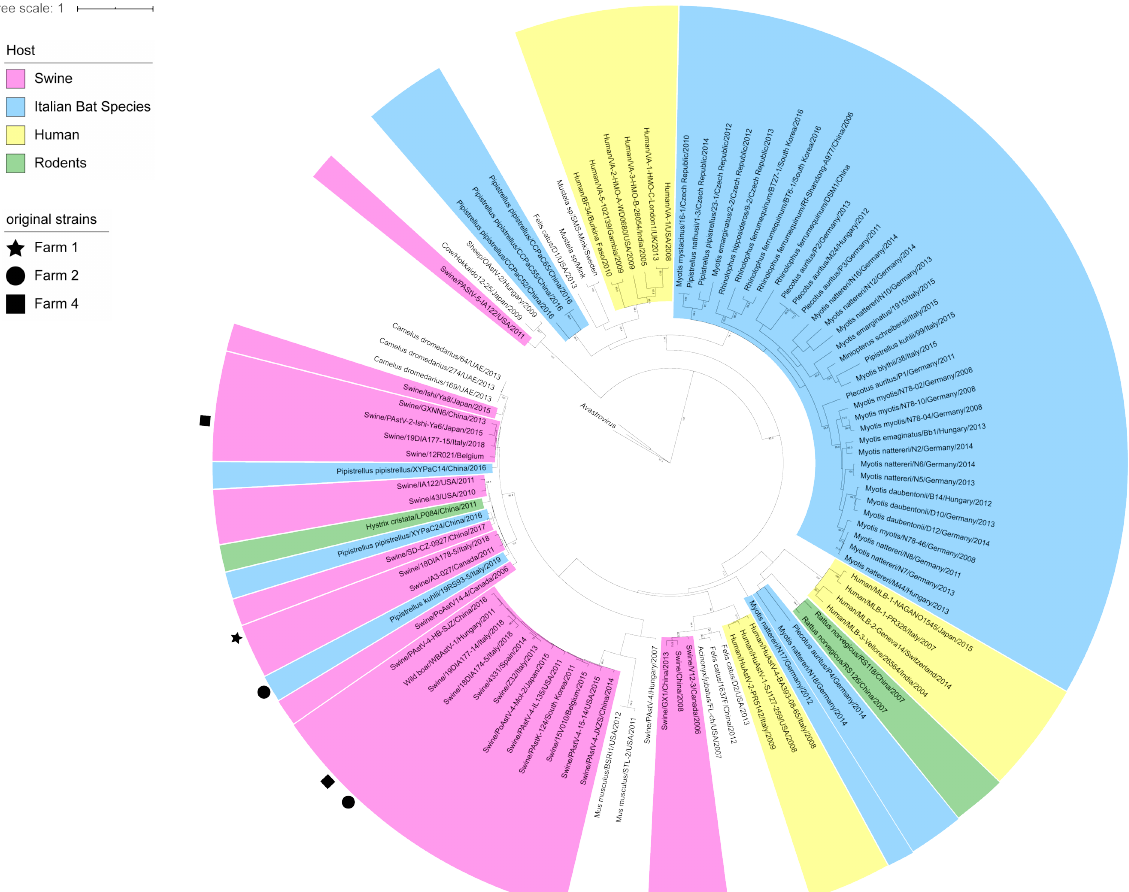
Figure 3. Phylogenetic tree based on the RdRp of mamastroviruses. Sequences are coloured based on the host species, with original sequences marked according to the farm of